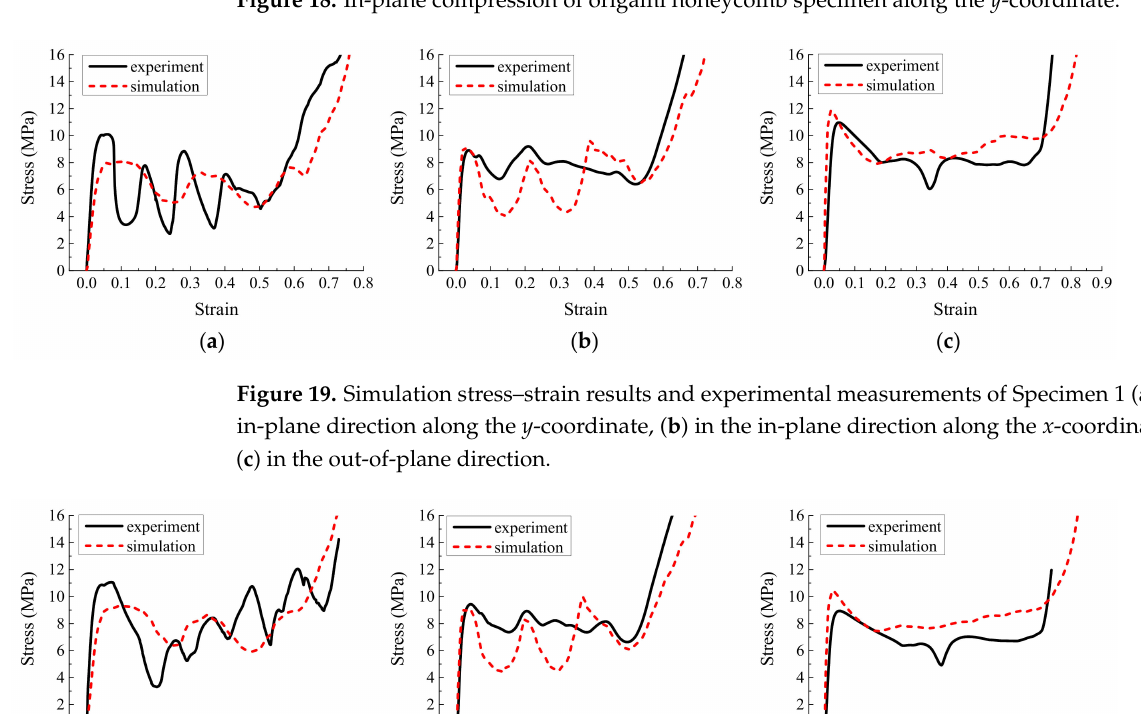
Figure 18. In-plane compression of origami honeycomb specimen along the y -coordinate.